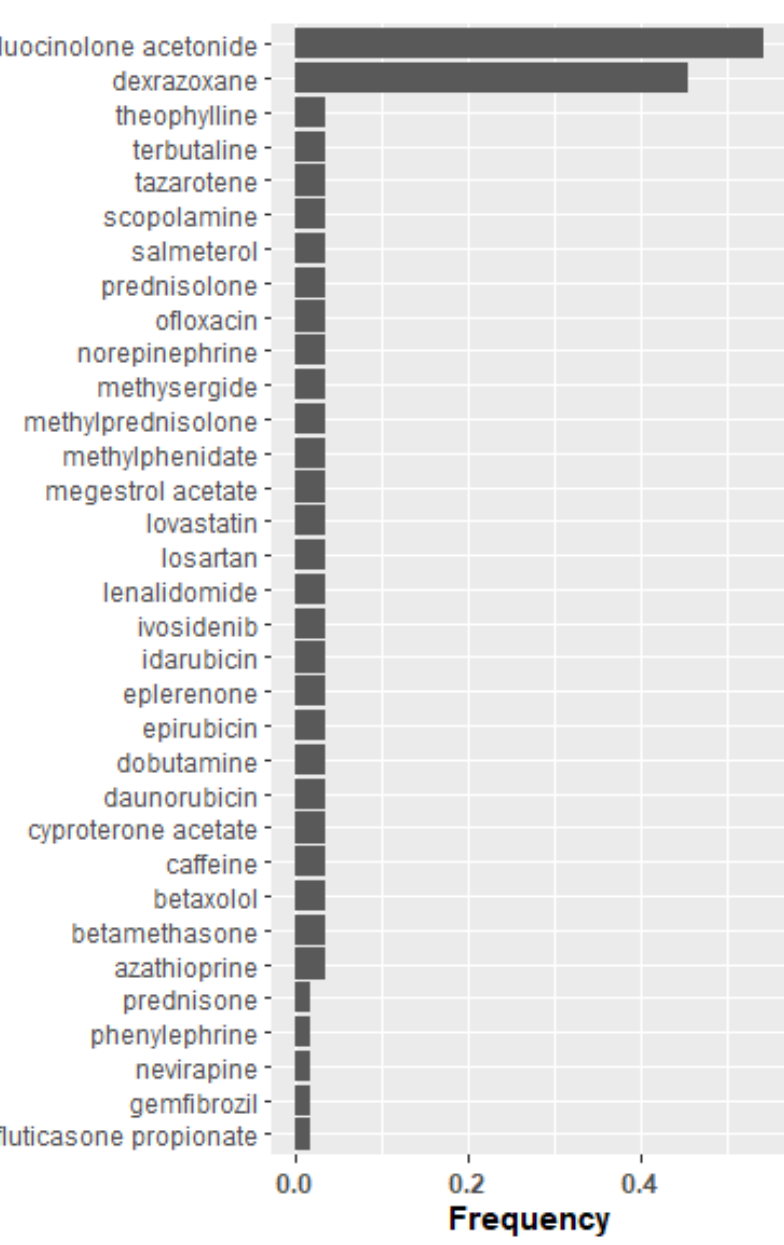
Figure 3. Drug frequency amongst idealized drug combinations predicted to modulate central pro- teins in COPD. The drugs initially identified by CANDO, which were predicted to activate or inhibit the four central nodes with the highest maximum betweenness centrality, are listed earlier (Figure 2). Specifically the drugs are predicted to promote central node proteins which were downregulated in the COPD cohort and inhibit central node proteins (identified by network topological graph), which were overabundant in the COPD cohort. The idealized drug vector constitutes interactions leading to desirable modulation of the central hub protein. Representation of individual drug frequency among the 57 significantly enriched two-drug combinations (idealized drug vectors) out of the 39 proteins represented in the Elsevier knowledge graph are listed in descending order. Fluocinolone acetonide and dexrazoxane appeared in 54% and 46% of all significantly enriched two-drug combinations, respectively, which is far greater than other drugs appearing in these combinations. The combination of fluocinolone acetonide and dexrazoxane is the most enriched two-drug combination leading to an idealized drug vector that most likely reverses the protein levels of the four central nodes to levels found in healthy control